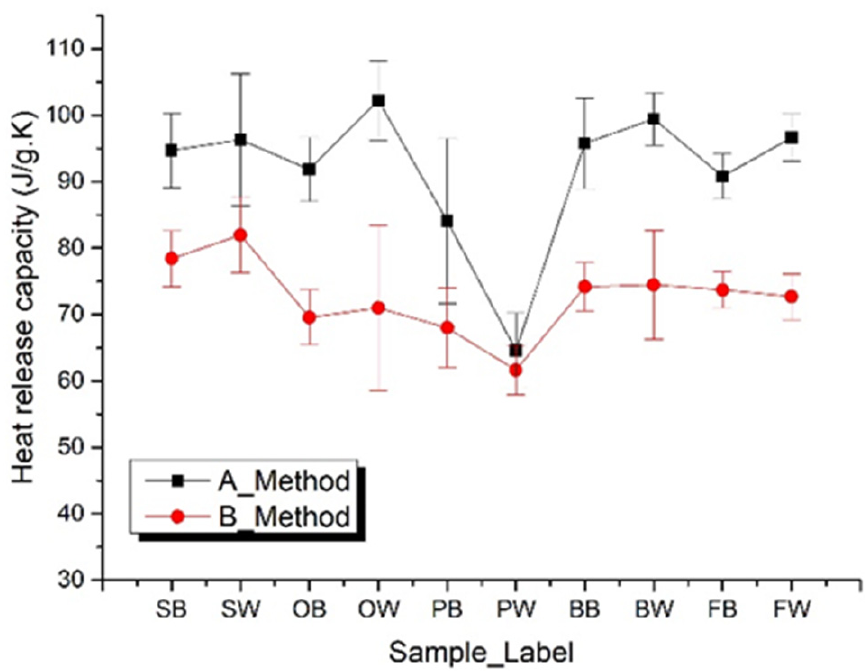
Figure 8. Heat release capacity defined by 20 W/g and 5% total heat release for results by Methods A and B.